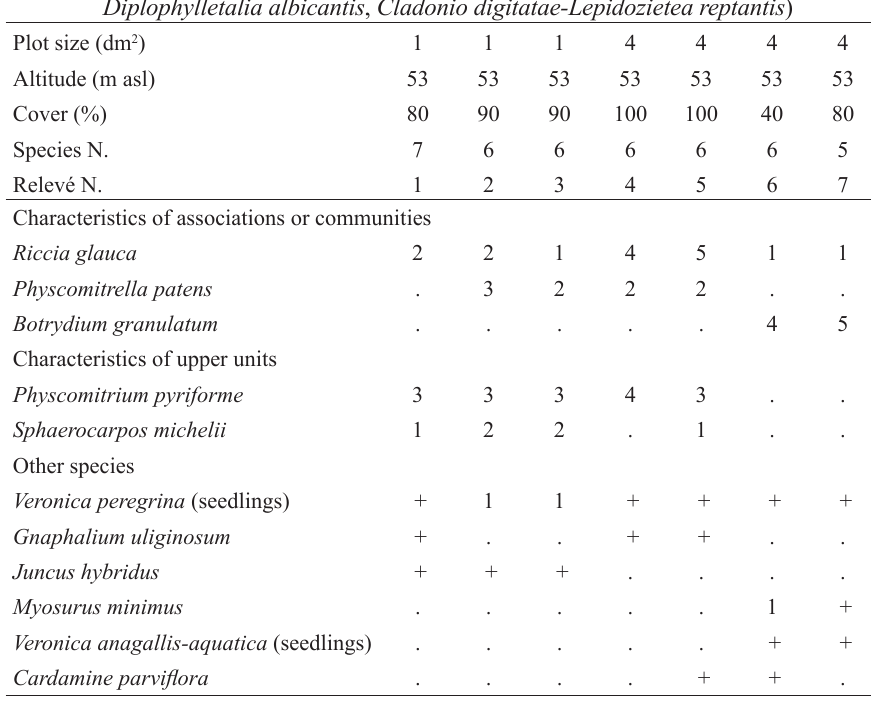
Table 2. Thallophytic communities on silty soils. Riccia glauca comm. (rel.